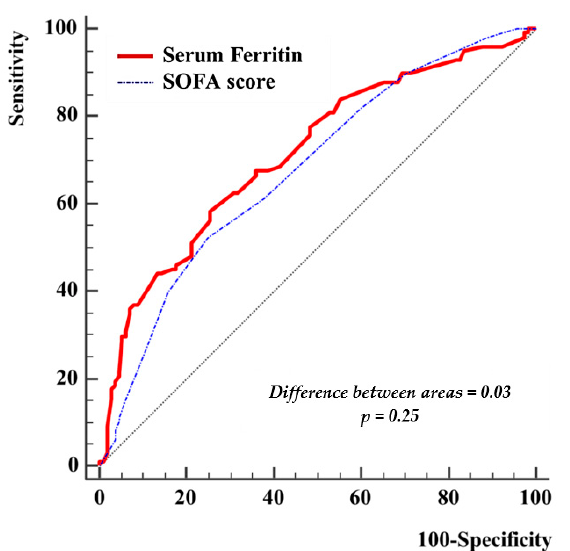
Figure 6. Pairwise comparison of receiver operating characteristic (ROC) curves for serum Ferritin and SOFA score. and SOFA